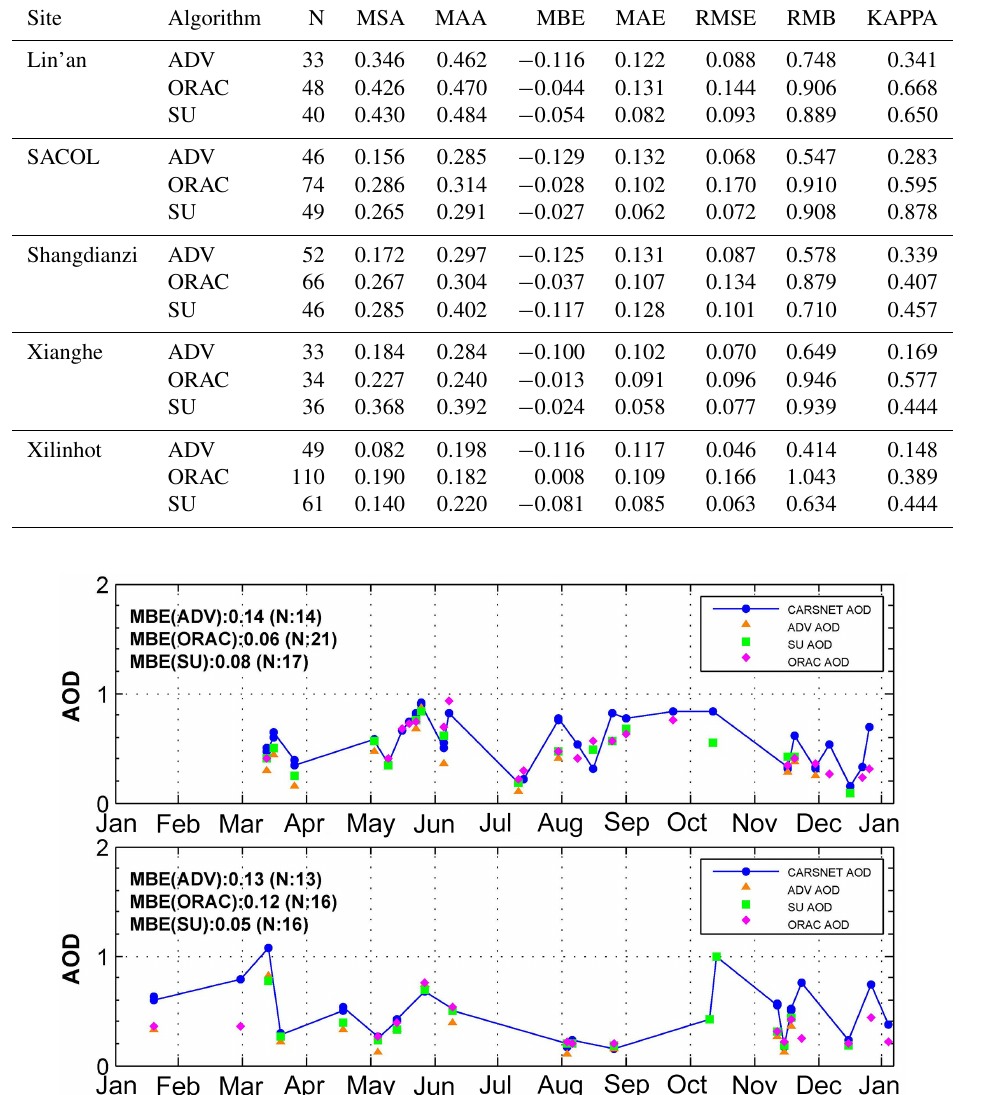
Figure 5. Time series comparison of AATSR AOD with CARSNET AOD at Lin’an in 2008 and